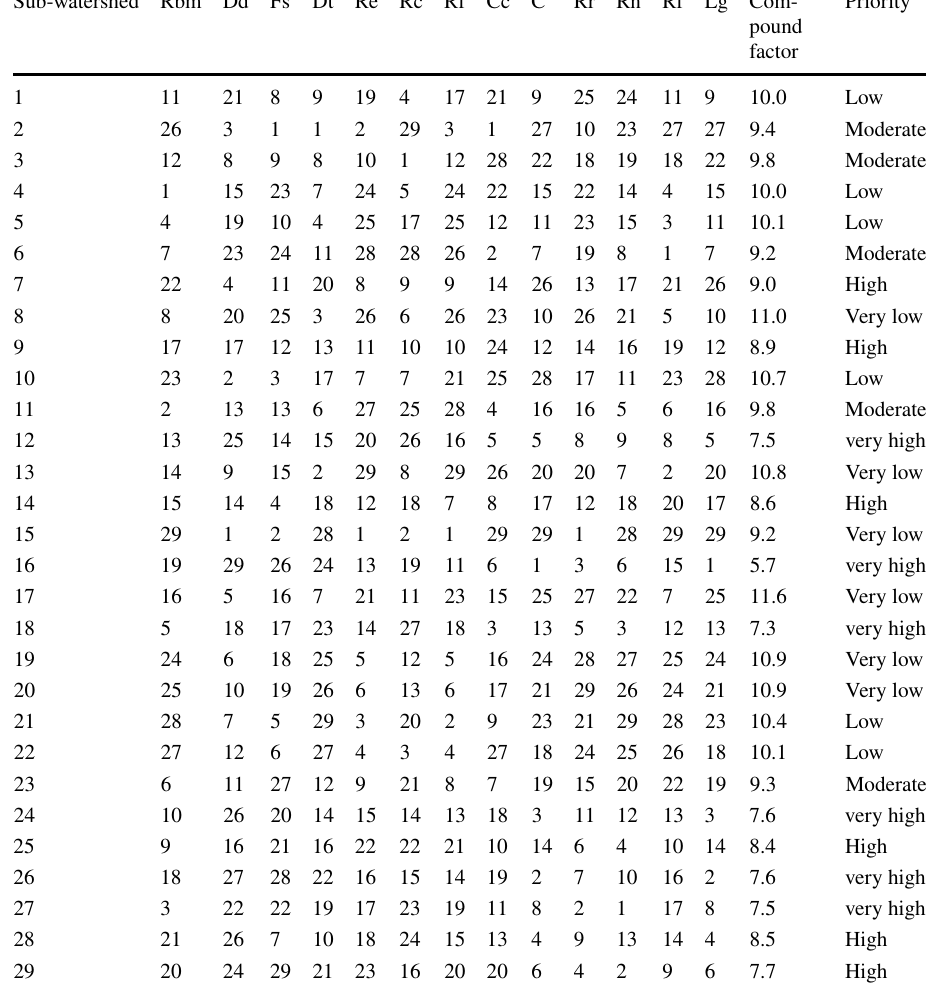
Table 9 Sub-watershed compound factor and